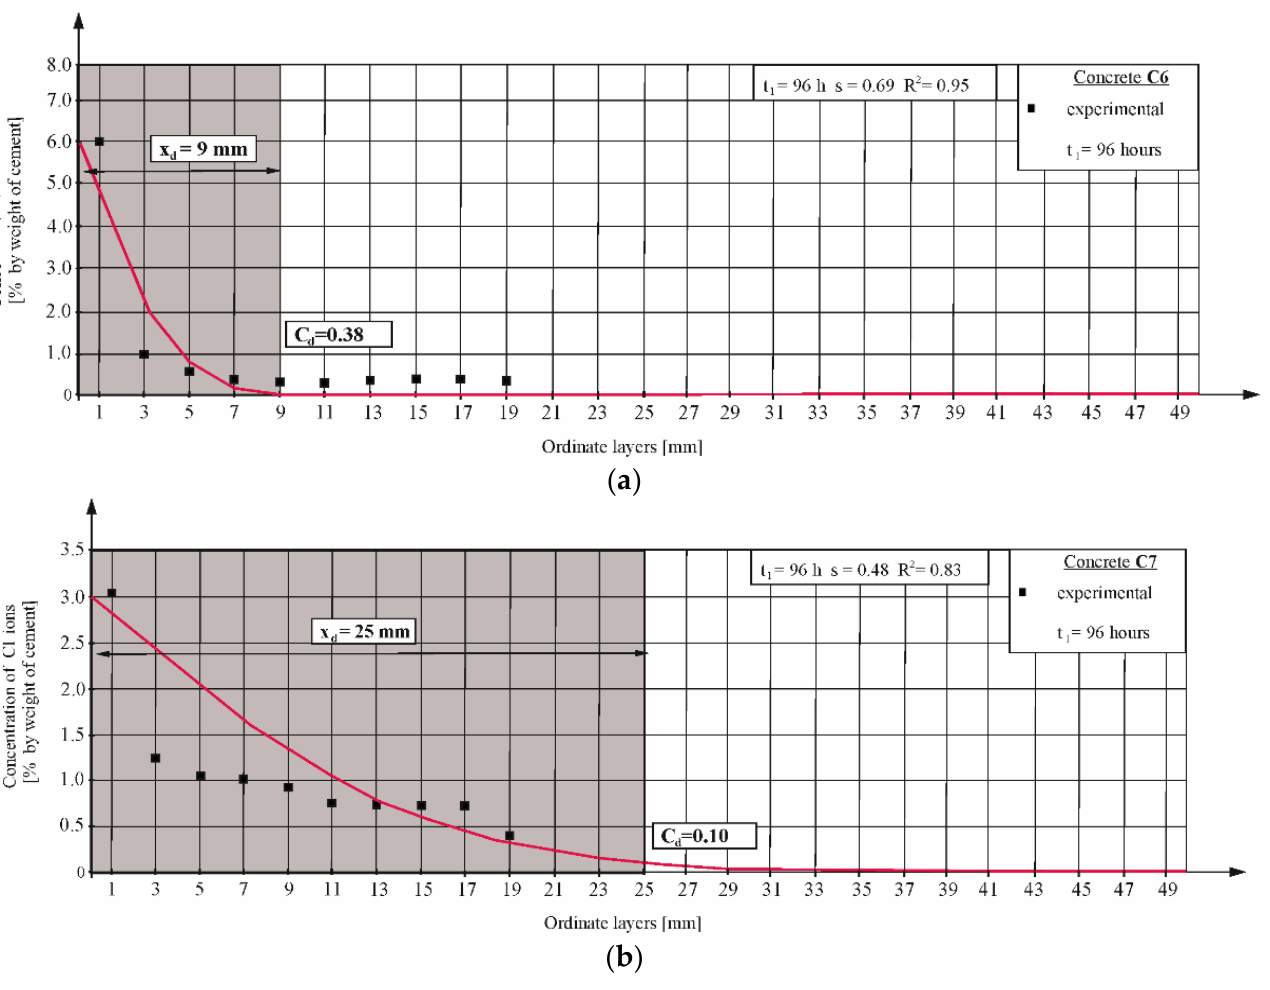
Table 7. Comparison of chloride concentration 𝑐 𝑑 related to chloride penetration depth 𝑥 𝑑 ac- cording to NT BUILD 492 (RCPT2).